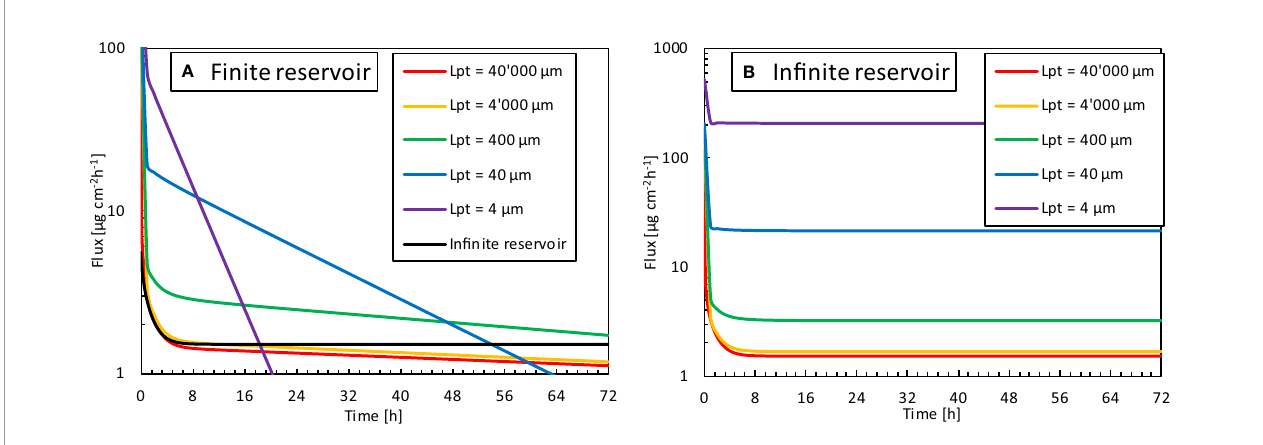
reservoir surface areas for fi nite and in fi nite reservoirs. In Figure 14 , the released fl ux at equilibrium (for an in fi nite reservoir) is shown as a function of reservoir width (L pt ), where the reservoir width is made dimensionless with the epidermal thickness ( d ep = 85 m m).